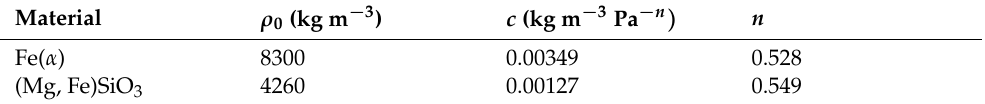
Table 1. Best-fit parameters for the SKHM equation of state (Equation (5)) obtained in [14].